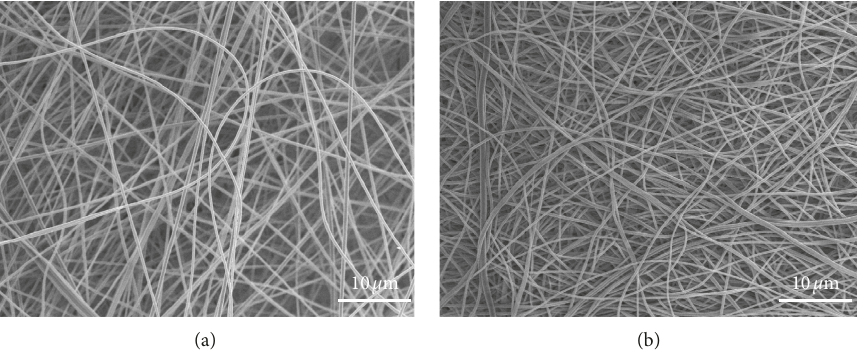
Figure 5: SEM images of (a) GES-25 and (b) GES-25/EMImBF